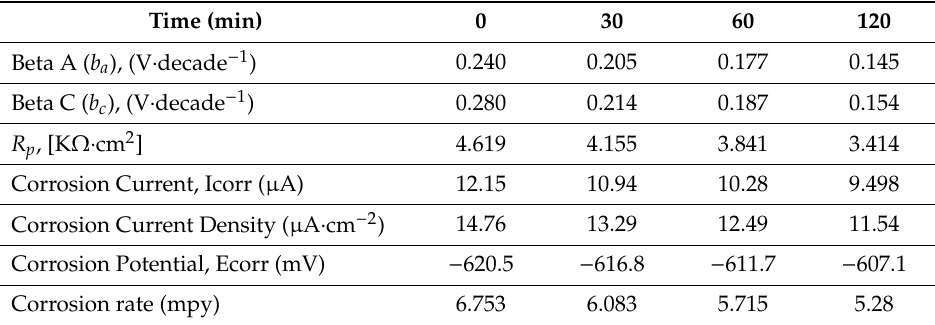
Table 7. E ff ect of immersion time on corrosion rate of API-X120 in GTL water at 303 K. Table 7. Effect of immersion time on corrosion rate of API-X120 in GTL water at 303 K.